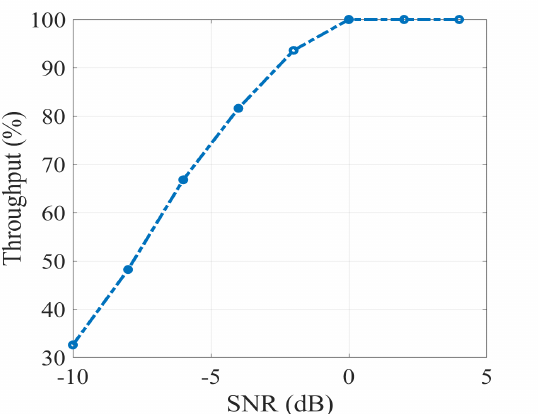
Figure 12. Variation of throughputs of the classification performance of the QS-SVM-based beam- former in terms of SNRs consistent with Figure